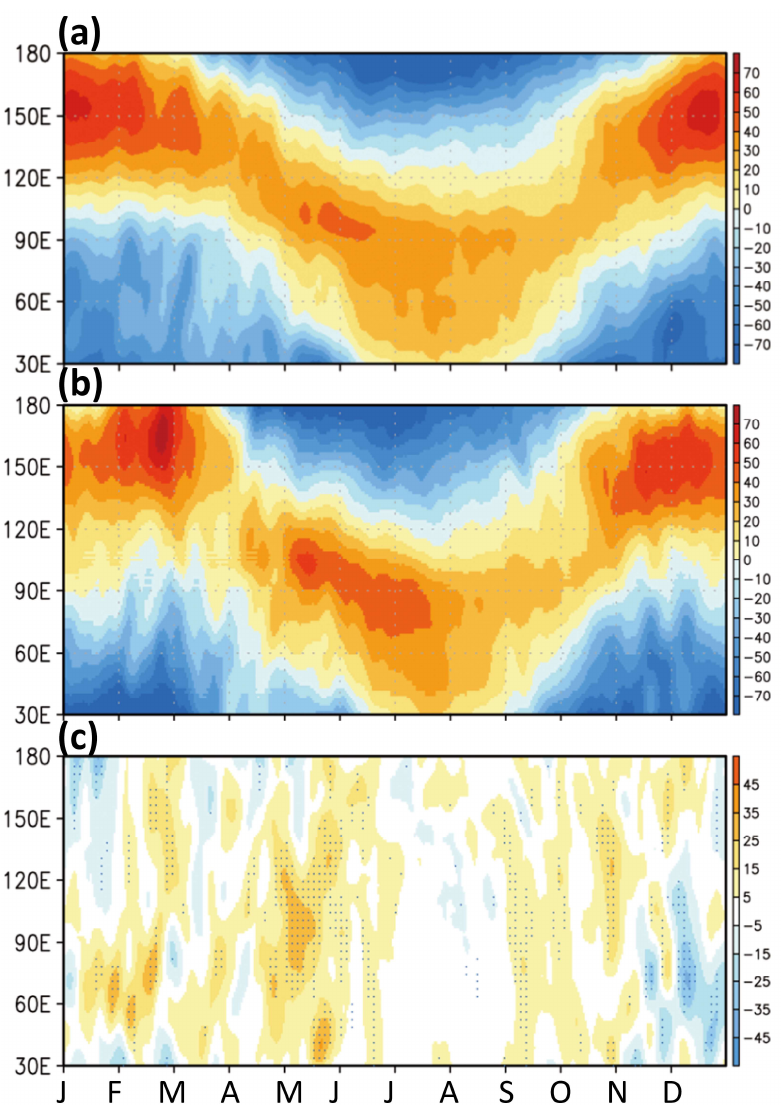
Figure 9. Longitude–time cross sections of eddy geopotential heights (gpm; average in 30° E–180° E has been subtracted) at 200 hPa in 15° N–25° N: ( a ) CFSR data; and ( b ) AA simulation. ( c ) Geopotential height differences between the two simulations (AA minus IP0). Dots denote that the differences have a confidence level of 90%.